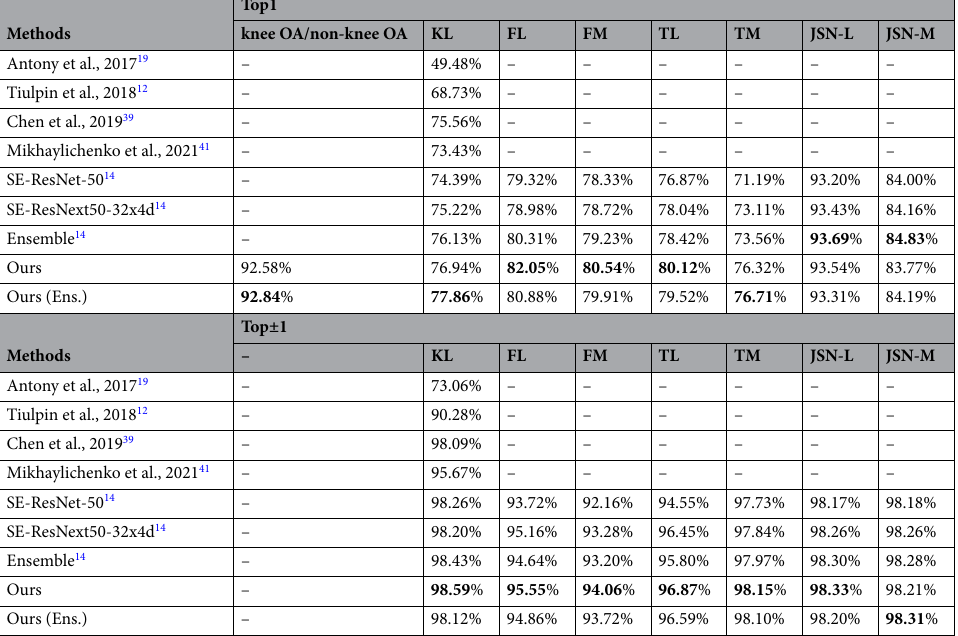
Ablation study. To verify the effectiveness of each module, ablation study is conducted. SE-ResNext50-32x4d model using the whole knee joint as input is our baseline, which grades seven tasks (i.e., KL and OARSI). Supple- mentary Table 7 and Table 8 illustrate their experimental results, where we can find that Siamese SE-ResNext50- 32x4d (baseline+Siamese) model exceeds baseline in most cases in terms of top1 and top±1 accuracy on the OAI and MOST datasets. Thus, it proves that two image blocks as input are beneficial to extract more sufficient local features than the whole knee joint as input, enhancing the classification performance. When we add knee OA/ non-knee OA classification task on the basis of Siamese SE-ResNext50-32x4d (baseline+Siamese) model, they also show that adding prediction task obtains higher top1 accuracy and top±1 accuracy than baseline+Siamese model on two datasets. Obviously, adding knee OA/non-knee OA binary classification in the final prediction layer is helpful to improve prediction performance of individual knee OA features grades by facilitating richer knee OA features extraction. In supplementary Table 7, the top1 accuracy of assessing individual knee OA fea- tures via our proposed method that applies adaptively gated feature fusion module is superior to that of ignoring this module under most circumstances on the OAI dataset. Meanwhile, supplementary Table 8 describes that our method has better performance in all top1 accuracy compared with baseline+Siamese+knee OA/non-knee OA task. The top±1 accuracy of our method is higher than that of baseline+Siamese+knee OA/non-knee OA task apart from for FM grades prediction. Therefore, adaptively gated feature fusion module further boosts performance of individual knee OA features assessment, which highlights more valuable contrast features and semantic information of key regions. Analyses. Above ablation study demonstrates the effectiveness of each module in our proposed method. Com- pared with single-task methods (i.e., Antony et al. 19 , Tiulpin et al. 12 , Chen et al. 39 , Mikhaylichenko et al. 41 ) that merely predict knee OA KL grades, our proposed methods not only realize fine-grained knee OA features grades prediction, but also achieve better classification performance in KL grades prediction, mainly presenting higher top1 accuracy, top±1 accuracy, Kappa coefficient and lower MSE in KL prediction. Additionally, we observe that Chen et al.’s method 39 shows superior performance in top±1 accuracy due that its ordinal loss considers the closeness between different categories. Approaches (i.e., SE-ResNet-50, SE-ResNext50-32x4d and ensem- ble models) proposed by Tiulpin et al. 14 are currently advanced in grading individual knee OA features. Our proposed methods have obvious superiority over methods of Tiulpin et al. 14 , acquiring higher top1 accuracy, top±1 accuracy, Kappa coefficient and lower MSE in most cases. We analyse the reasons as follows: (1) The SE- ResNext50-32x4d network is a deeper and more discriminative architecture, where SE-ResNext module helps to capture value features and suppress meaningless ones. (2) A Siamese network with SE-ResNext50-32x4d backbone can extract more sufficient local features since the left and right image patches are passed to SE- ResNext50-32x4d respectively. (3) Multi-task prediction can promote each other due to correlation among knee OA/non-knee OA, OARSI and KL, making the model pay more attention to osteophytes and joint spaces and extracting more critical features. (4) The adaptive gated feature fusion method is used for feature fusion of two parts, further filtering features of two parts to emphasize useful information and suppress the useless informa- tion by adaptive weighting. (5) We also propose an ensemble model consisting of two networks, where one